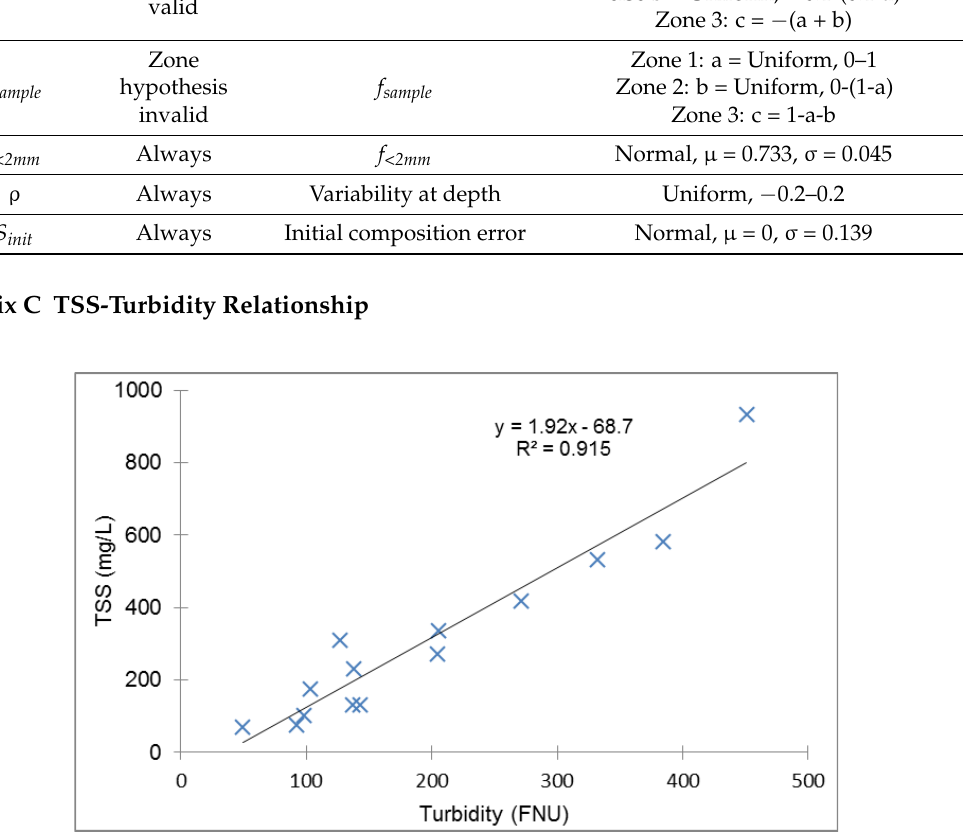
Figure C1. Event mean TSS-turbidity relationship for sampled events Figure A2. Event mean TSS-turbidity relationship for sampled